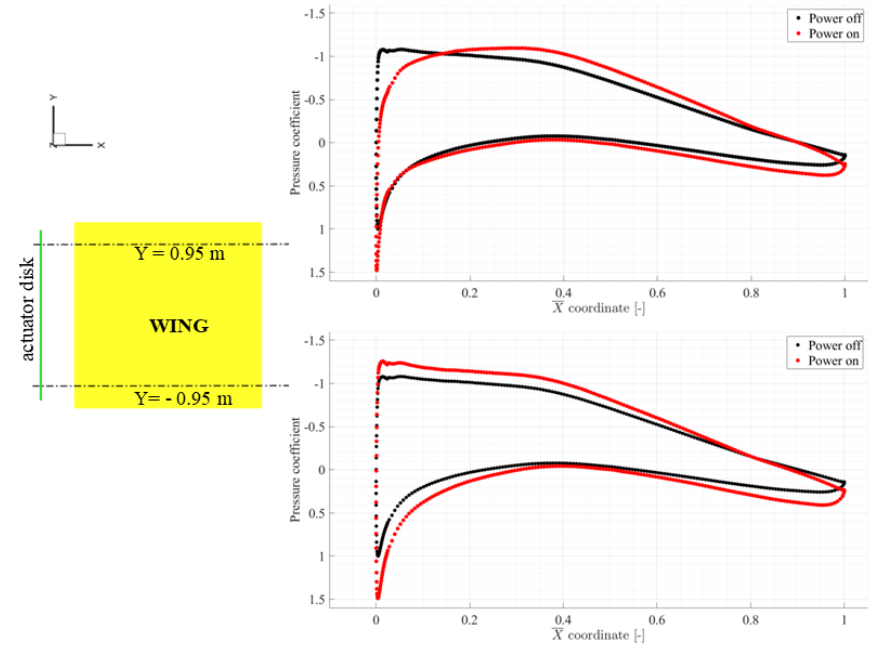
Figure 16. Pressure coefficient comparison. Power-off vs. power-on at α = 4 ◦ deg. ANSYS- FLUENT tool.